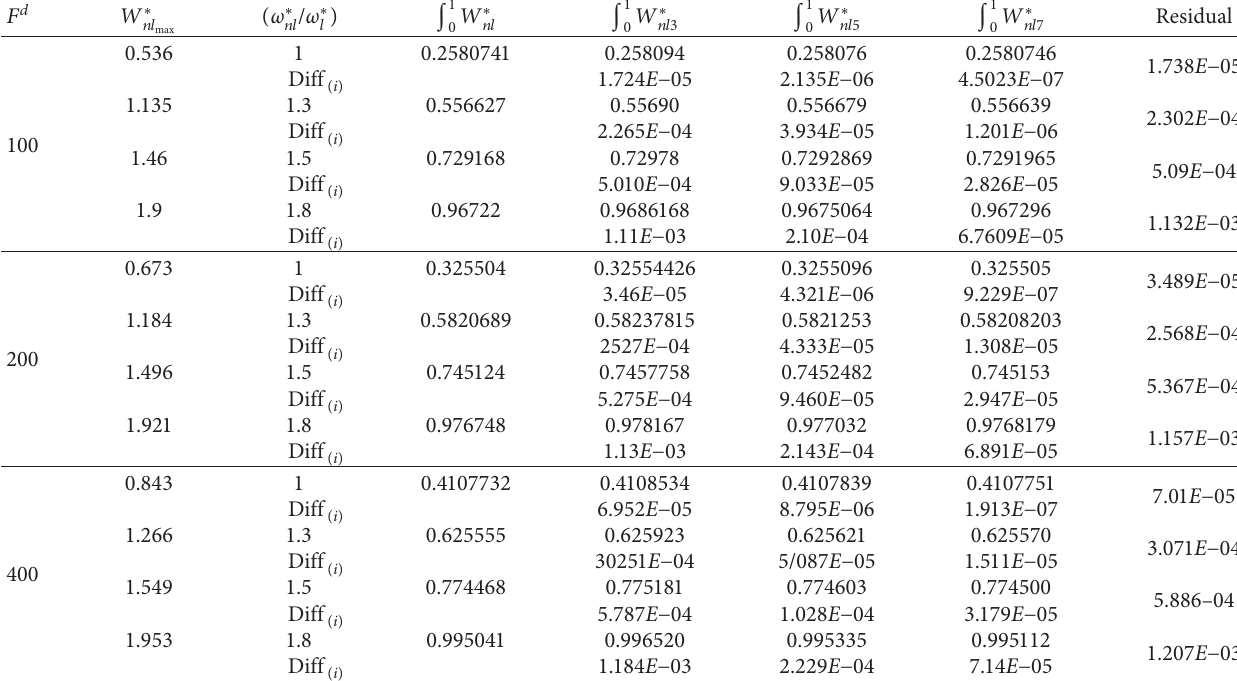
W ∗ | |( d 2 W ∗ /d x ∗ 2 )| 0